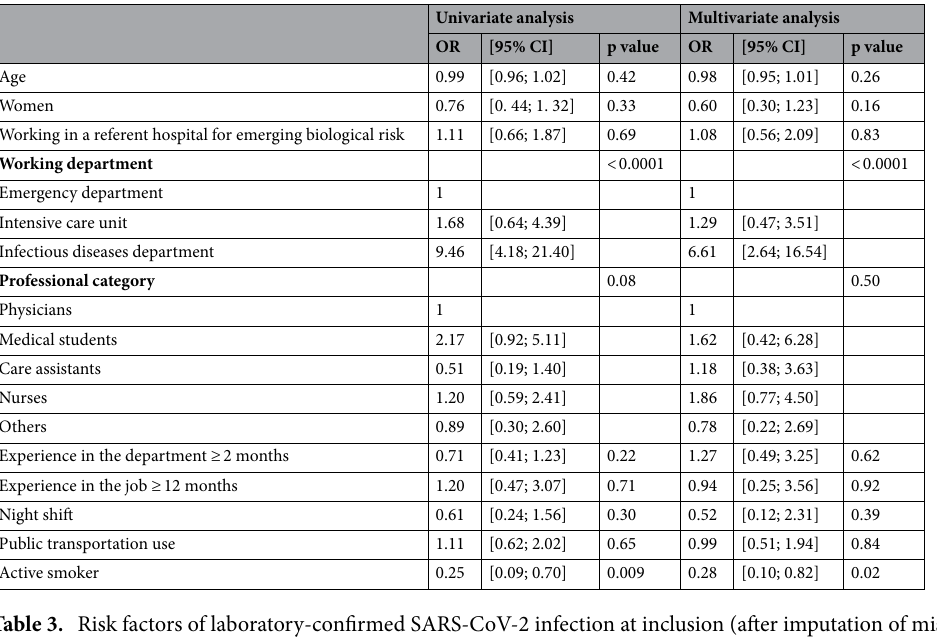
Table 3. Risk factors of laboratory-confirmed SARS-CoV-2 infection at inclusion (after imputation of missing data; N = 1017). HCWs from virology department were excluded because none had a positive serology result at inclusion. Others include (but not limited to): secretaries, nurse’s managers, social workers. OR odds ratio, CI confidence interval.